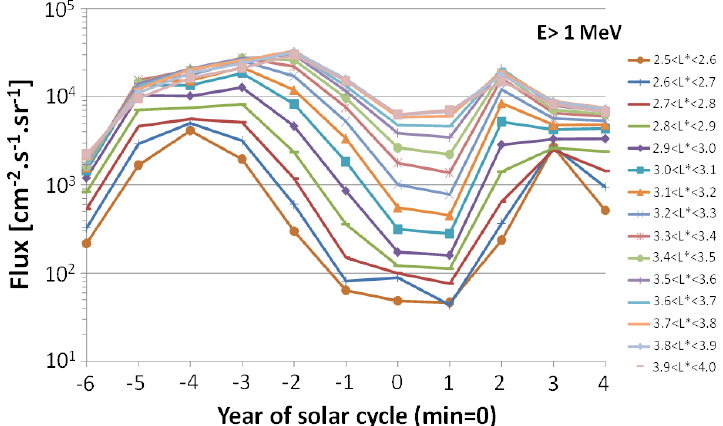
Figure 7. Electron >1MeV fluxes vs. year of the solar cycle from all NOAA-POES data for each L ∗ interval defined in the SLOT model.